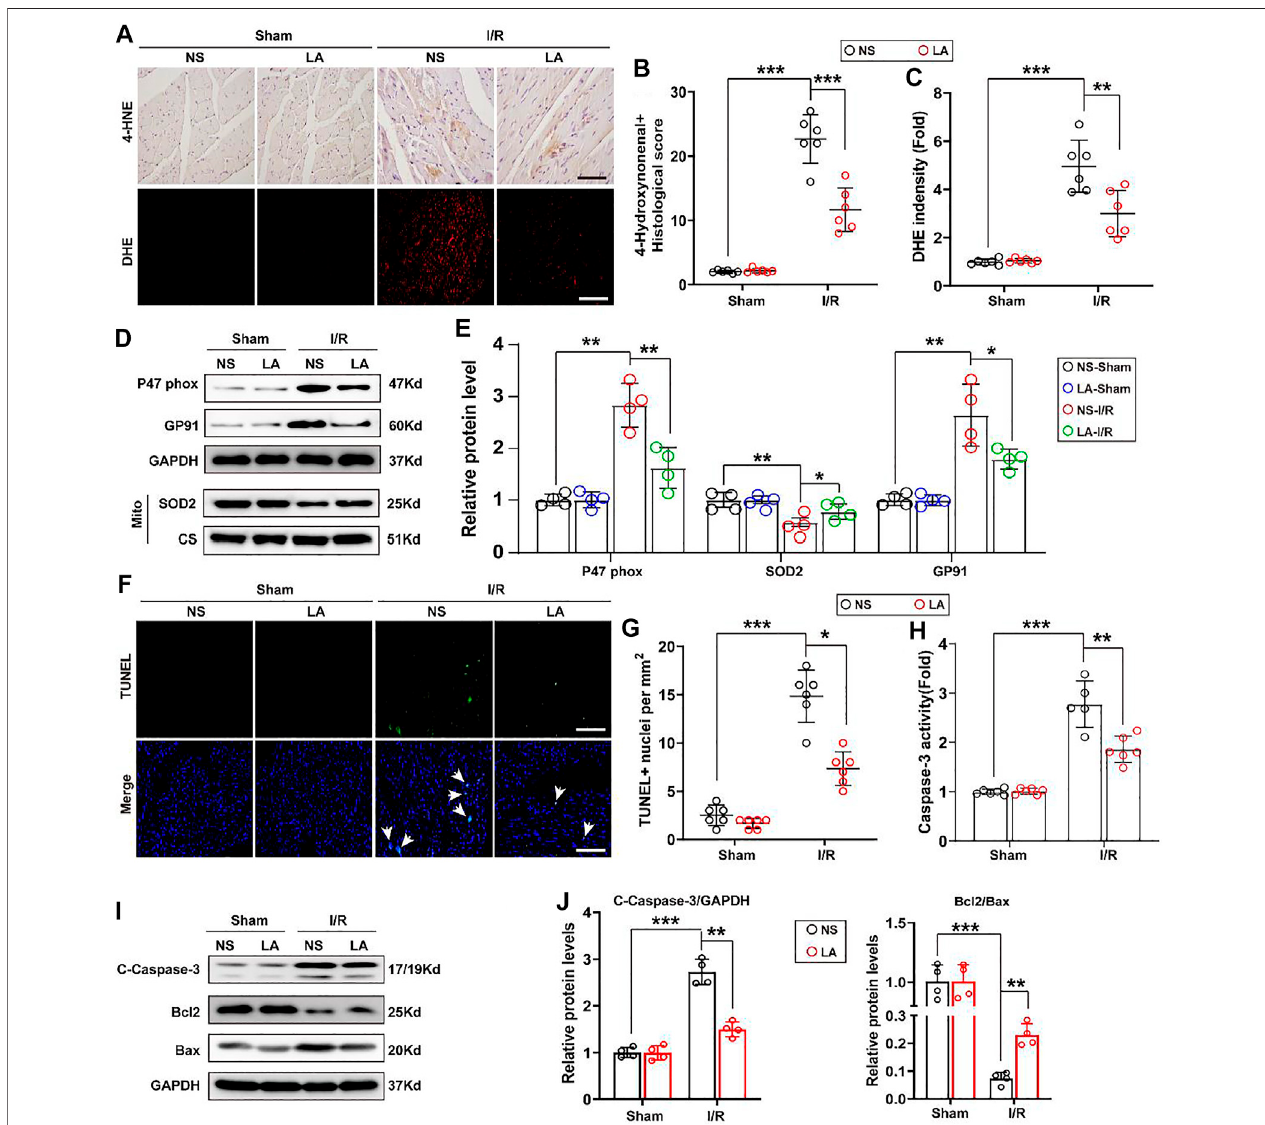
FIGURE3| LAattenuates oxidative stressandapoptosisfollowing MI/Roperationinheart. LAandNSpretreated mice weresubjected toMI/R operationorsham, and then hearts were harvested for histologyand molecularanalysis (A – C) . Representativeimmunohistochemistry of4-hydroxynonenal and DHEstaininginhearts, and intensity analysis ( n (cid:1) 6). Scar bar: 100 μ m (D,E). Representative western blot and analysis of p47 phox, SOD2 and GP91 in hearts, normalized to GAPDH ( n (cid:1) 4) (F,G) . Representative Tunel and positive cells analysis in hearts ( n (cid:1) 6). Scar bar: 100 μ m (H). Caspase-3 activity was tested in heart tissues ( n (cid:1) 6) (I,J).